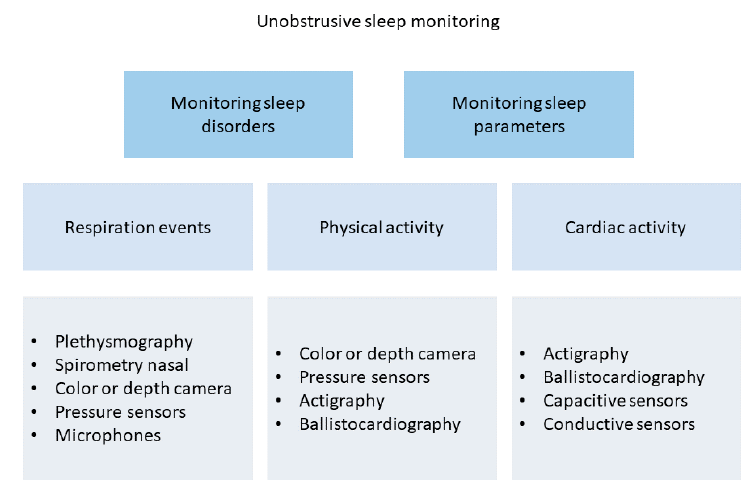
Figure 15. Taxonomy of existing unobstrusive methods for sleep assessment.